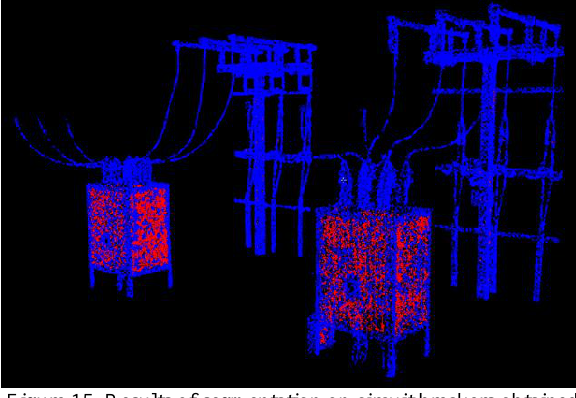
Figure 15. Results of segmentation on circuit breakers obtained by PCA using down-sampled Faro subset